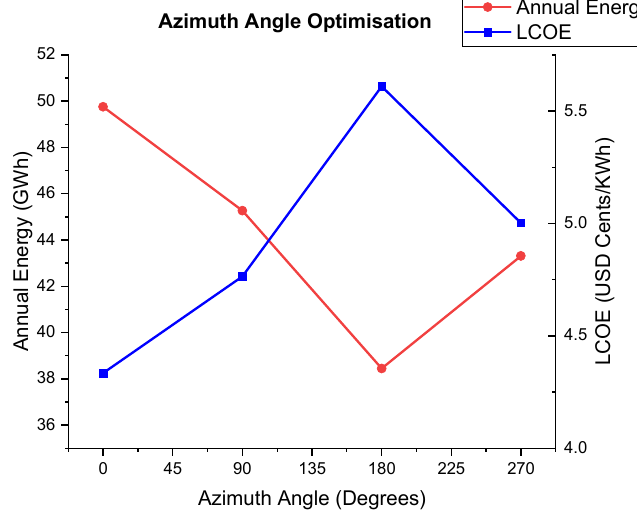
Figure 8. Variation of the annual energy and the LCOE with a tilt angle.